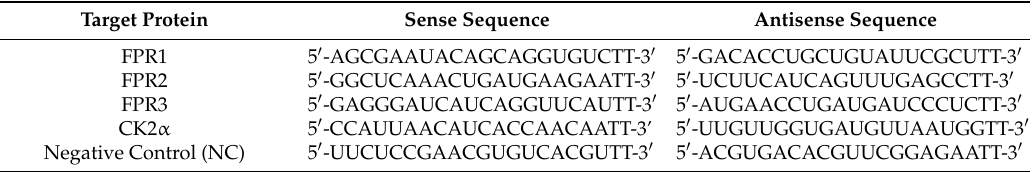
Table 1. Sequences for small interfering RNA (siRNA)